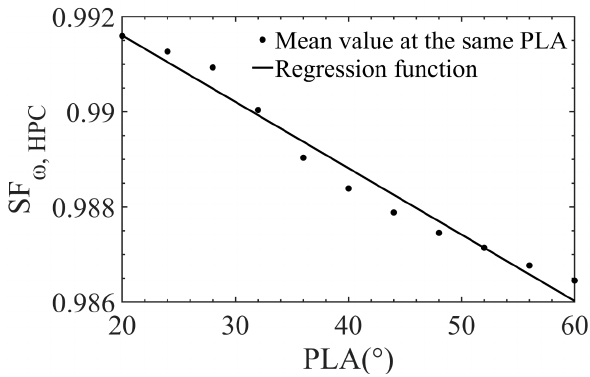
Figure 8. Regression analysis result of the mapping relationship: Case 2.